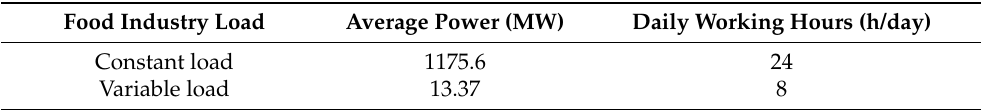
Table 7. Food industry load curves in Shams Abad (full-load